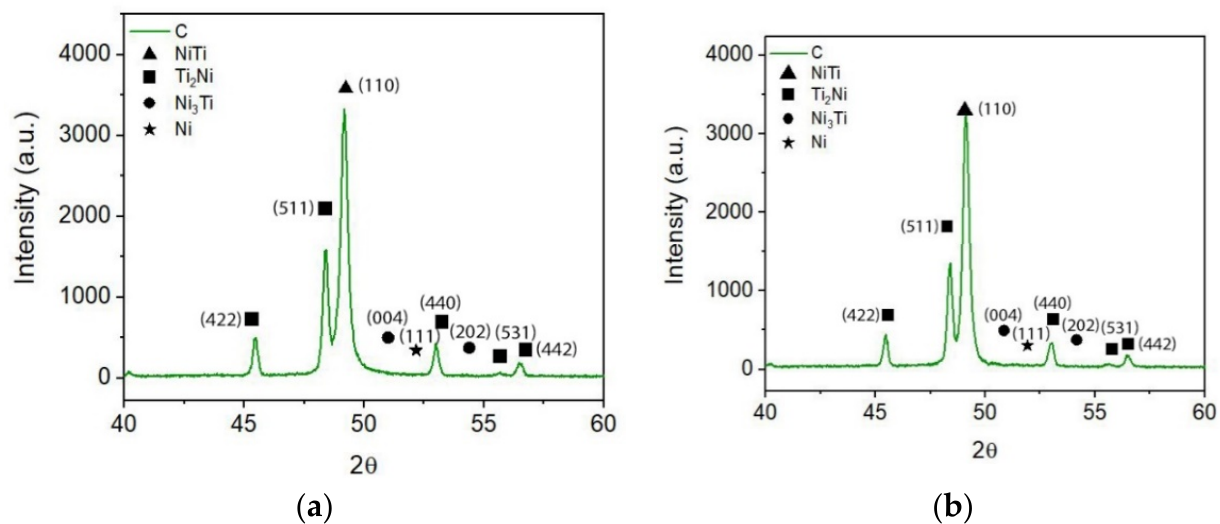
Figure 10. X-ray diffractograms of 3D object from filament C. ( a ) top, ( b ) bottom. Composition D has a supplementary content of Ni (6.2 wt.%) mixed with virgin powder (NiTi + NiTi 2 + Ni) and with 5 wt.% TiH 2 . This composition has two objectives: first to highlight the role of the excess of Ni in the Ni 3 Ti phase formed during processing, and the second, to analyze the role of the excess of Ni in the disappearance of NiTi 2 resulting from NiTi powder fabrication. In fact, with the addition of Ni, a drastic decrease of the NiTi 2 is observed, as evidenced in the SEM images of 3D object D (Figure 11) when compared to B (Figure 6) and C (Figure 8) 3D objects. Thus, powder Ni content could be tuned as a possible solution for the disappearance of NiTi 2 in order obtain only NiTi in prealloyed powders.